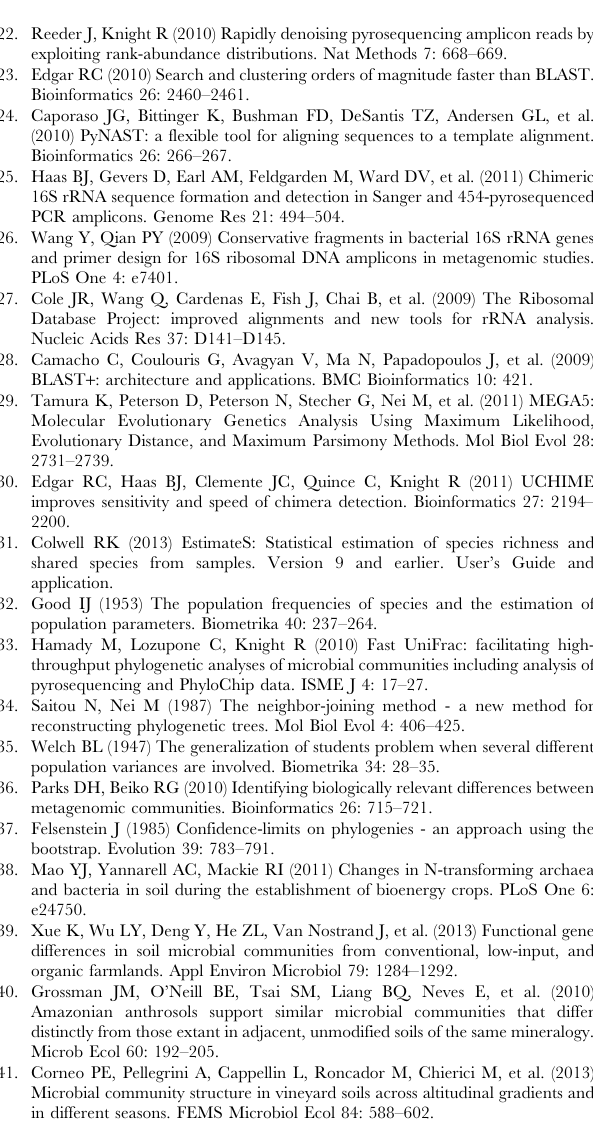
Figure S5 Correlation analysis of organic carbon con- tents and soil pH to Chao1 diversity indexes. Previously reported archaeal amoA pyrotag data from various soil environ- ments [14] were combined with those from niter-bed soils. (TIF) Table S1 Physicochemical parameters of niter-bed soil samples. (PDF) Table S2 Primer sequences for pyrotag analysis. (PDF) Table S3 The 16S rRNA gene pyrotag libraries of relict niter-bed soil. (PDF) Table S4 The OTU table of 16S rRNA gene pyrotag libraries. (PDF)